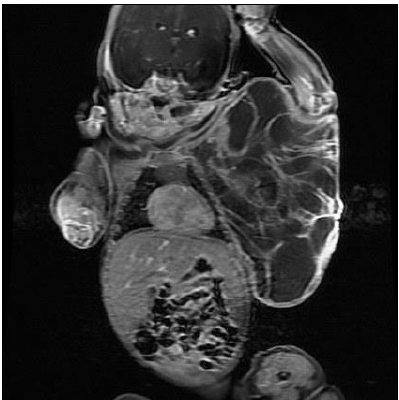
Figure 2: Magnetic resonance angiography that shows mass with characteristics of a hemolymphangioma.